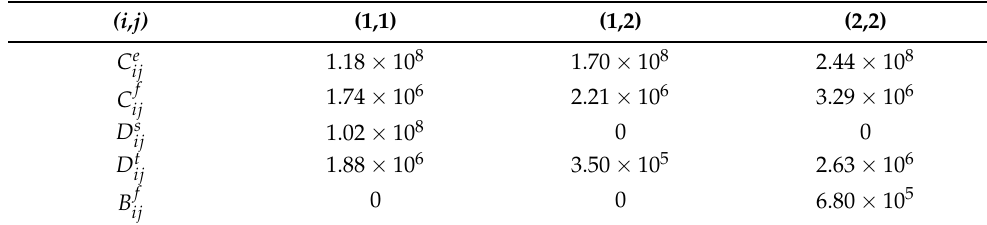
Table 1. Coefficients of the Generalized Beam Theory (GBT) equations.